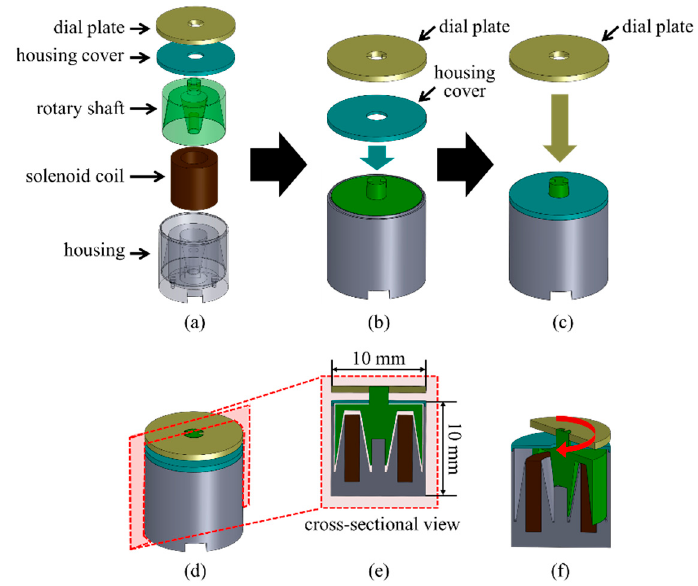
Figure 1. Schematic and cross-sectional illustrations of the proposed haptic knob: ( a – c ) assembling procedure of the proposed haptic knob; ( d ) assembled haptic knob; ( e ) its cross-sectional view, and ( f ) schematic illustration of the proposed haptic knob when it rotates